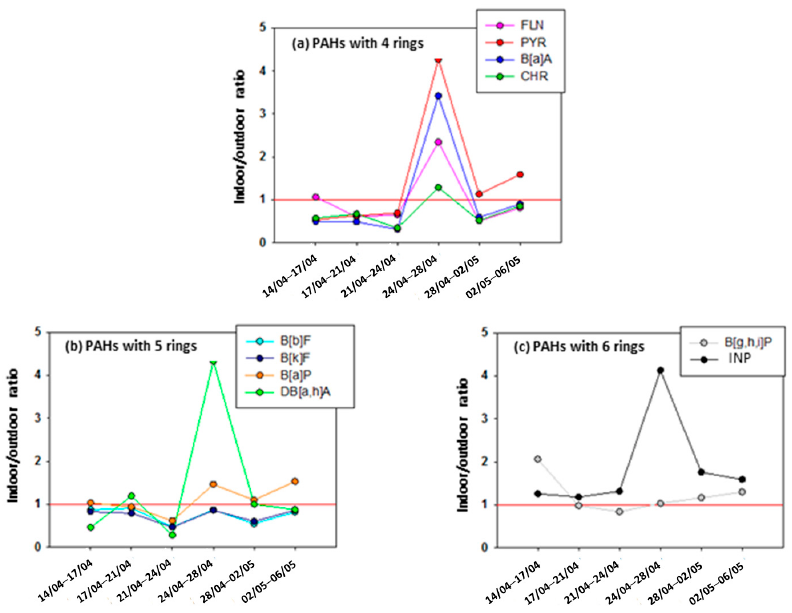
Figure 7. Indoor-to-outdoor concentration ratios (I/O) vs. time in 2014 for ( a ) PAHs with four rings, ( b ) PAHs with five rings and ( c ) PAHs with six rings. The PAH concentrations are calculated by summing the PAH quantity collected on all the plateaus of cascade impactor for a given sampling period. The red line corresponds to I/O = 1.